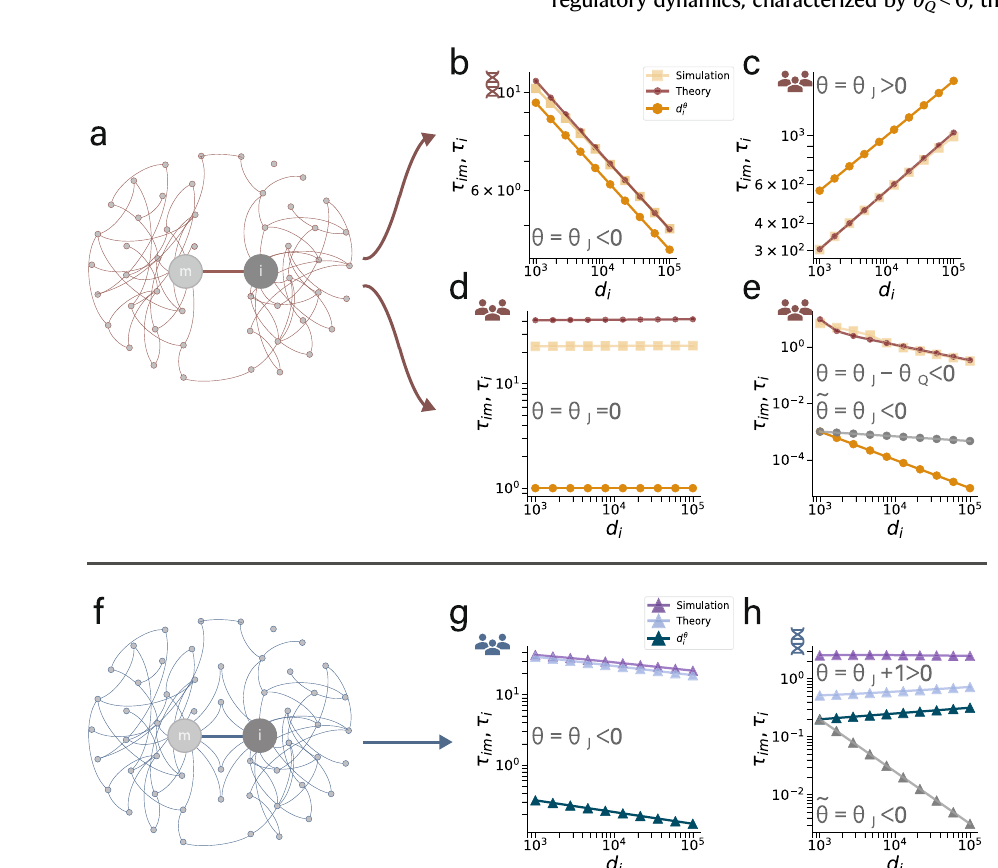
Fig.2|Responsetimescalingforlocalpropagation.a Networkwithperturbation at m with target node i having d i edges (referred to as independent edges). b Propagation time τ i (time from source m to i ) as a function of degree d i for network ( a ) with regulatory dynamics ( θ J = 1